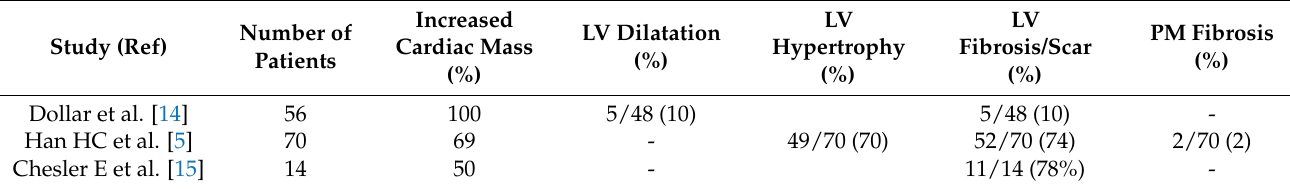
Table 1. Autopsy studies of SCD in